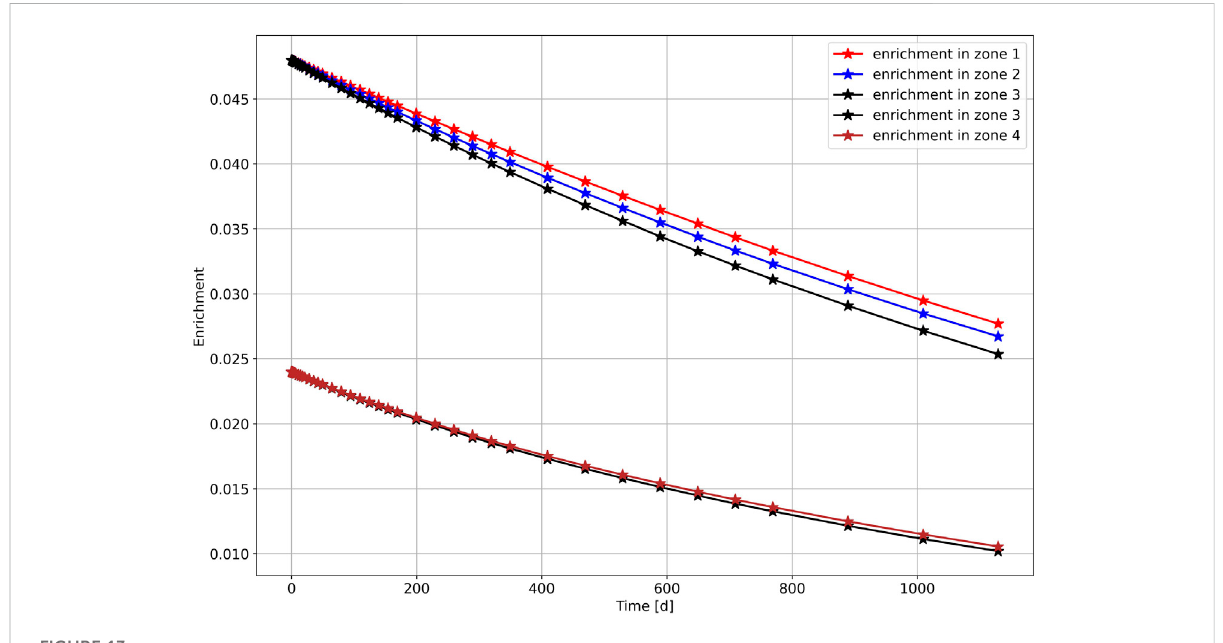
FIGURE 13 The enrichment variations in the radial burn-up